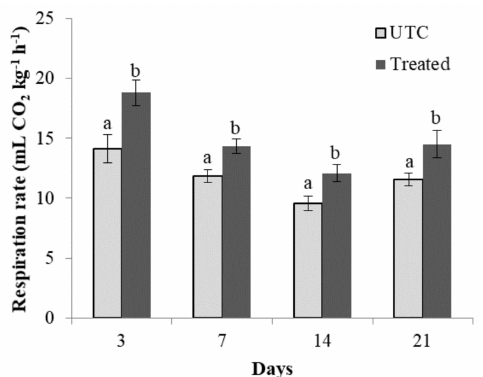
Figure 4. Fruit respiration rate (mL CO 2 kg − 1 h − 1 ) of treated and untreated (UTC) ‘Jiro’ persimmon fruit during storage at 15 ◦ C for up to three weeks. Data are means ( n = 3) and standard deviations around the mean are shown in error bars. Values with the same letter within each assessment time are not significantly di ff erent using the LSD test at p < 0.05.